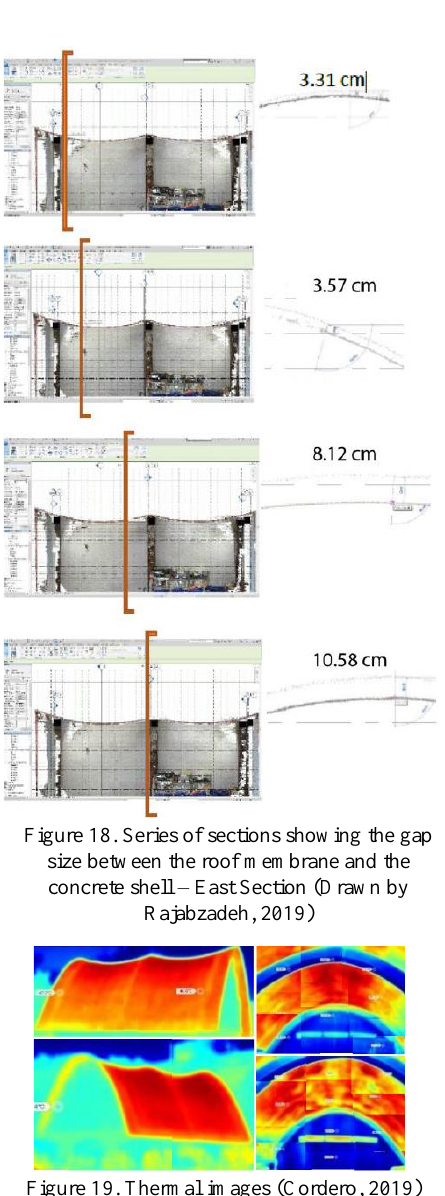
Figure 19. Thermal images (Cordero, 2019)